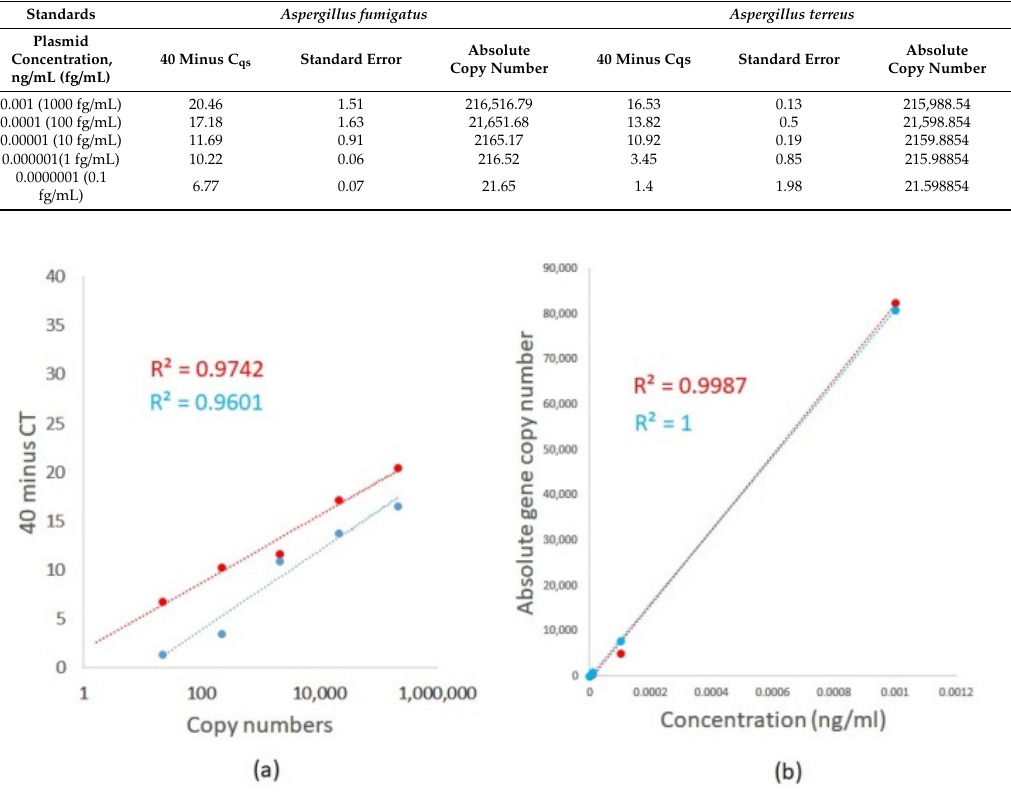
Figure 3. Limit of detection and absolute quantification of A. fumigatus (red line) and A. terreus (blue line) using ( a ) TaqMan qPCR and ( b ) ddPCR. 18S ITS DNA sequences of A. fumigatus and A. terreus were cloned into a TOPO plasmid vector and qPCR and ddPCR performed using 10-fold serial dilutions of plasmid from 1 pg / mL to 0.1 fg / mL. Absolute copy numbers are computed by using known sequence and plasmid concentrations (for TaqMan qPCR) and by identifying negative and positive droplets based on a Poisson distribution statistical algorithm (for ddPCR). Table 3. Table illustrating absolute copy numbers of A. fumigatus and A. terreus derived by ddPCR. Aspergillus fumigatus Aspergillus terreus Plasmid Concentration, ng / mL (fg /